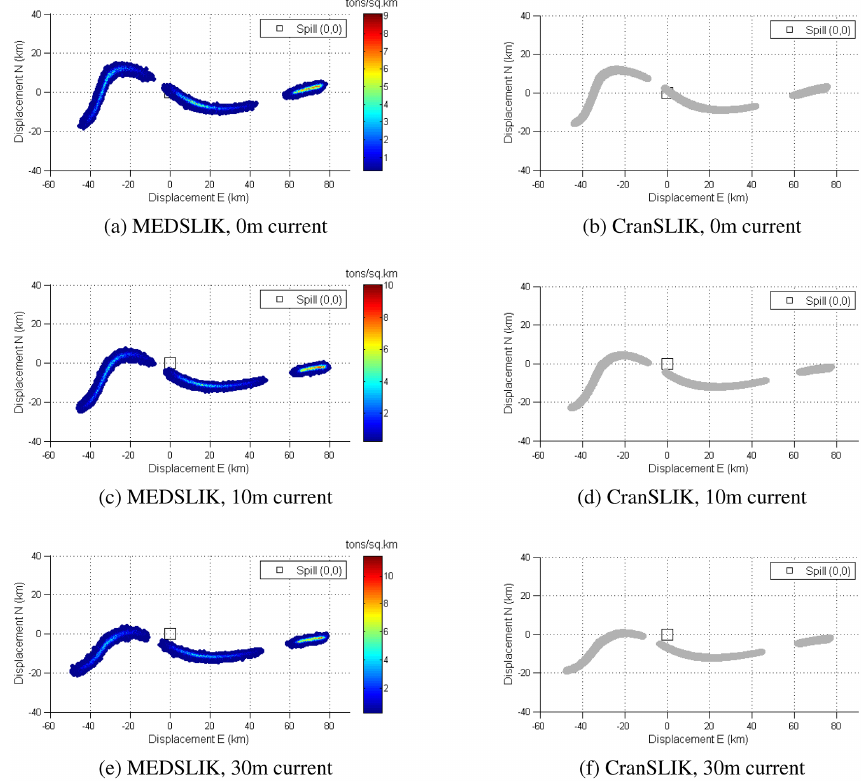
Figure 6. MEDSLIK and CranSLIK forecasts of slick after 36h for the Algeria contour case, using the current at different depths as the advective